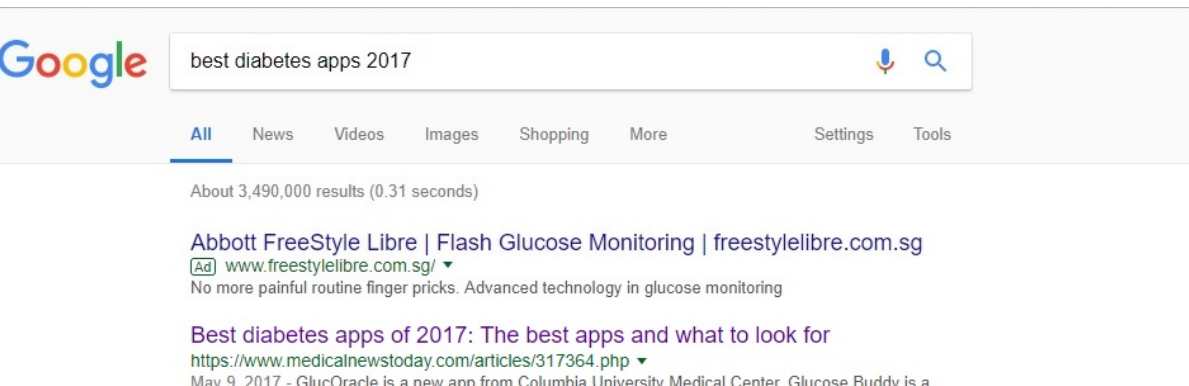
Figure 1. A screenshot of Google search for “best diabetes apps 2017.” Source: Google.com; screenshot taken by Geronimo Jimenez on April 20,